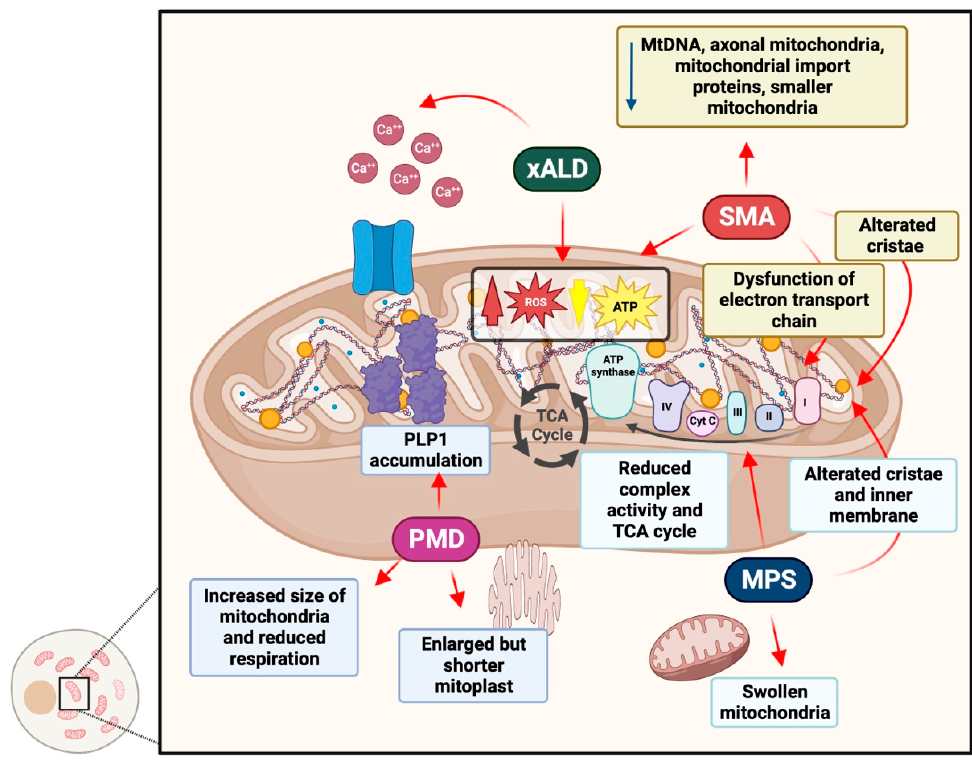
Figure 2. Schematic representation of mitochondrial damage mechanisms in some examples of pe- diatric-onset neurodegenerative diseases. pediatric-onset neurodegenerative